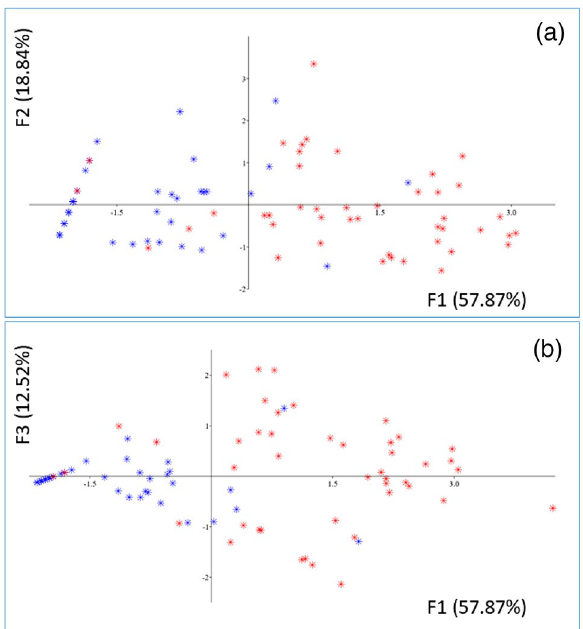
Figure 4. Data distribution by ( a ) 2D-scattered plot of the first two principal components (eigenvectors F1–F2); ( b ) 2D-scattered plot of first and third principal components (eigenvectors F1–F3). Data points arising from specimen collected in Site A (blue symbols) or Site B (red